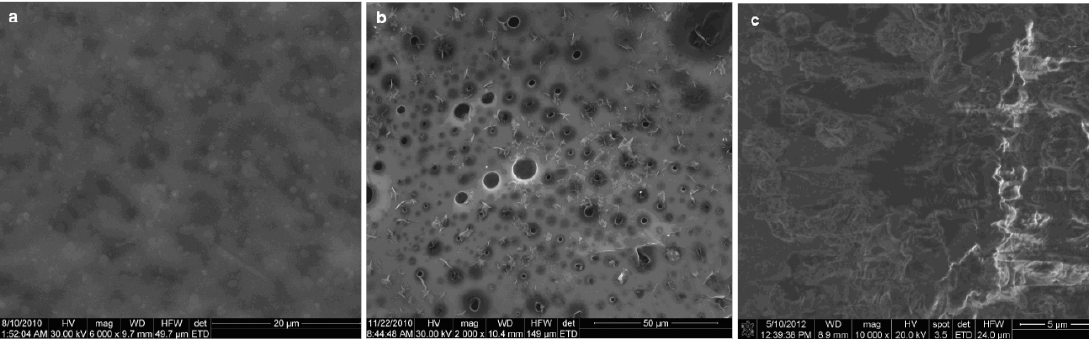
Figure 1. SEM images of: a) sPEEK membrane, b) sPEEK/PANi composite membrane, c) sPEEK/PpPD composite